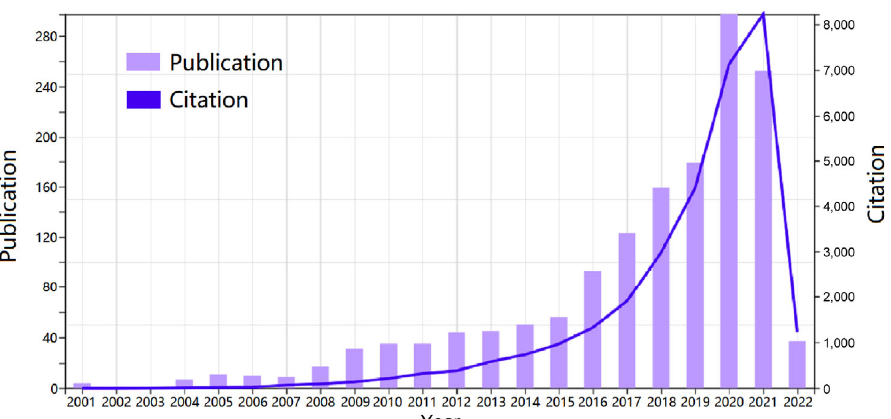
Fig. 1 Numbers of times cited and publications during 2001–2022. The data were compiled from the Web of Science database on March 16, 2022. (The topic words for retrieval are nano, additive, and oil.)